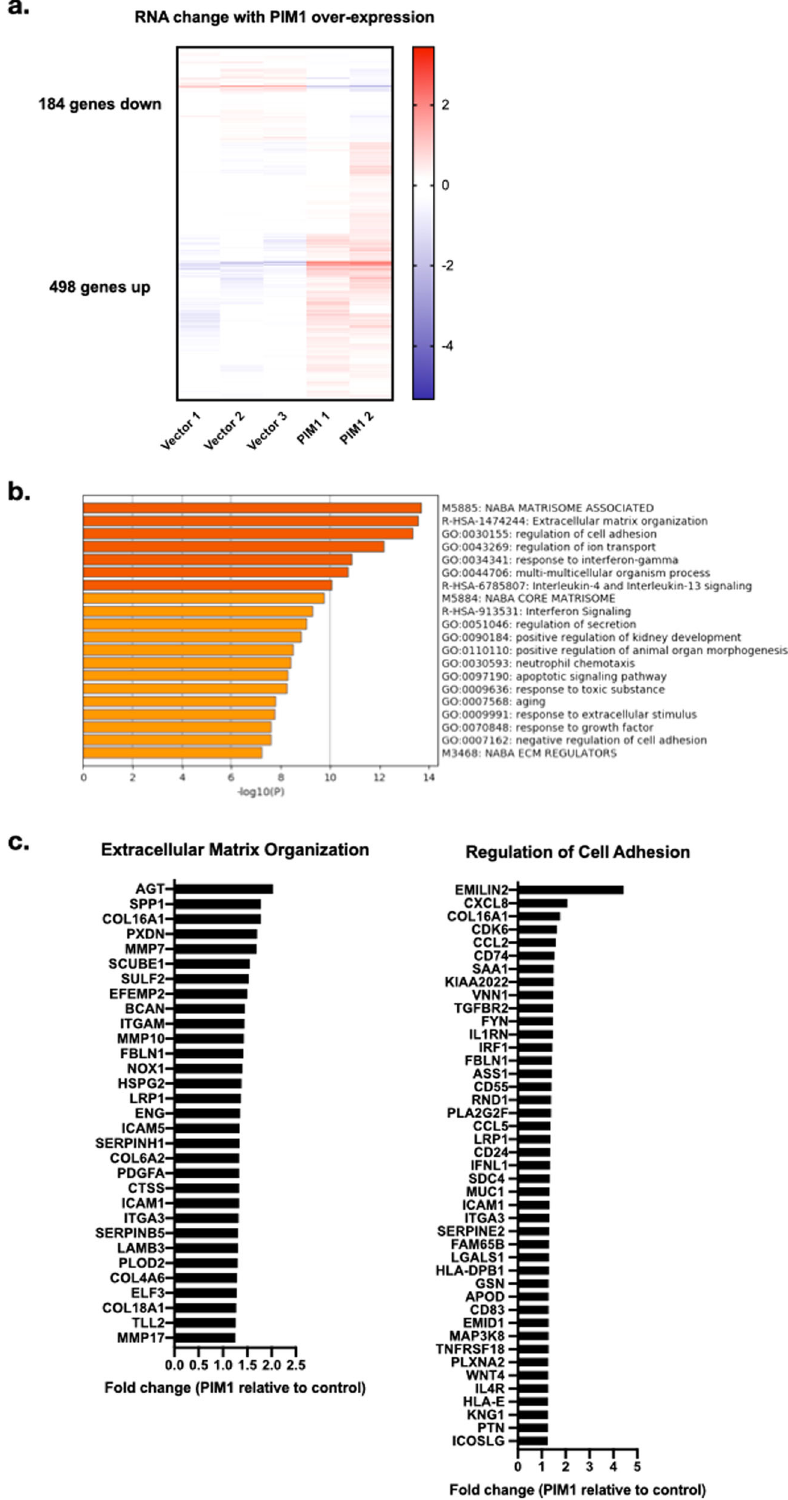
Fig. 2 PIM1 over-expression in LNCaP cells results in changes in gene expression involved in extracellular matrix organization, cell adhesion, and immune signaling. a PIM1 over-expression in LNCaP cells results in up-regulation of 498 genes and downregulation of 184 genes (1.25 fold change, p value < .05). b Metascape analysis of pathways for PIM1 upregulated genes shows that genes are involved in extracellular matrix organization, cell adhesion, and immune system processes. c Genes upregulated in extracellular matrix organization and cell adhesion include matrix metalloproteinases, collagen proteins, and immune system